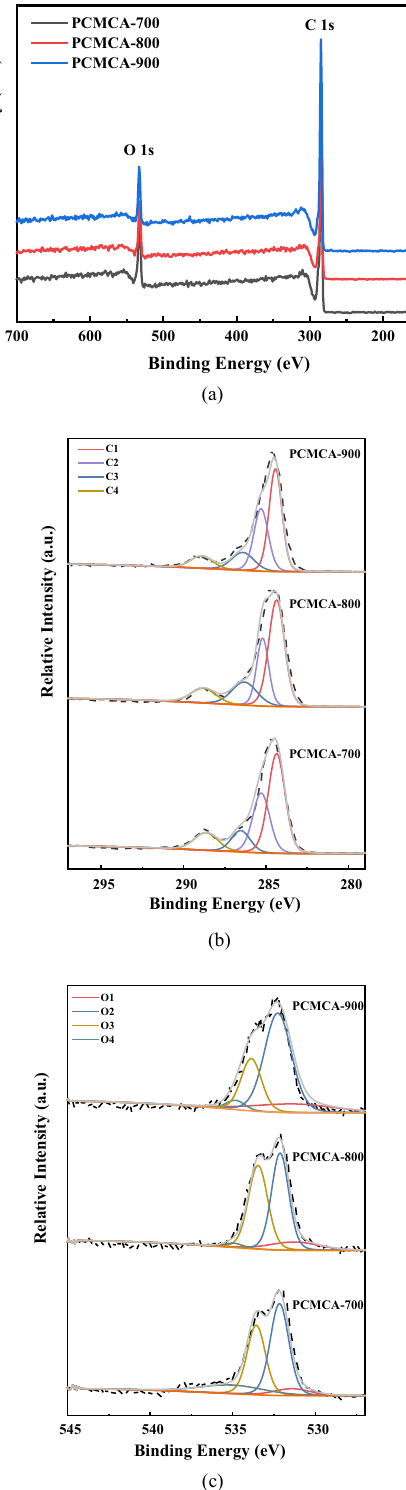
Fig. 3 a XPS full spectra and high-resolution spectra of b C 1 s and c